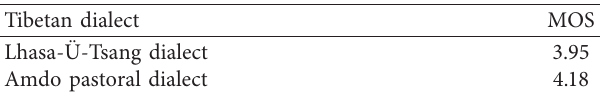
Table 3: The MOS comparison of speech synthesized by different synthesis primitive models.